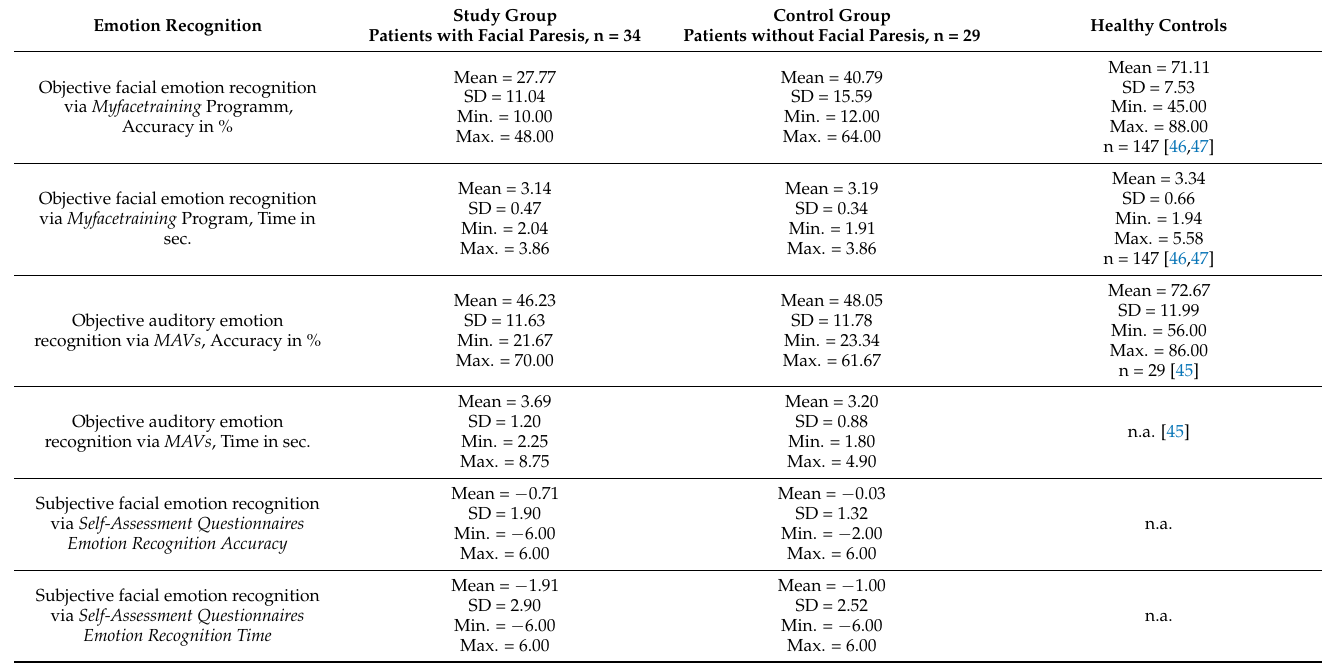
Table A4. The results for objective (accuracy and time) and subjectively perceived success in